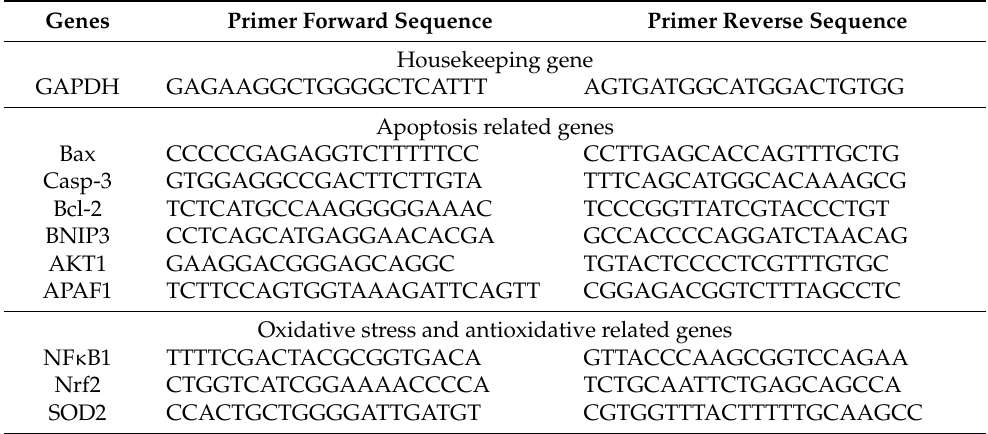
Table 1. The sequences of forward and reverse primers for oxidative stress and apoptosis related genes. Genes Primer Forward Sequence Primer Reverse Sequence Housekeeping